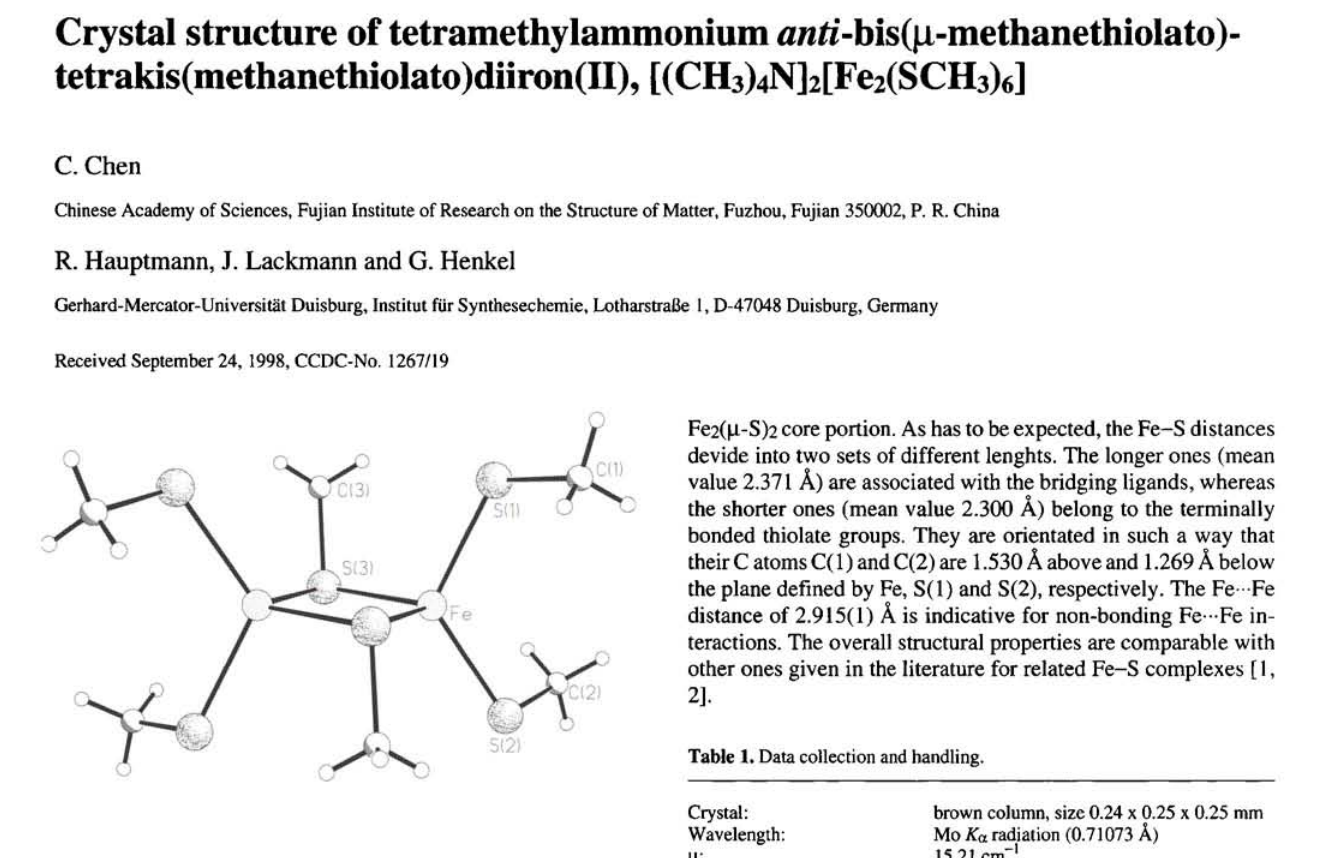
Table 1. Data collection and handling.